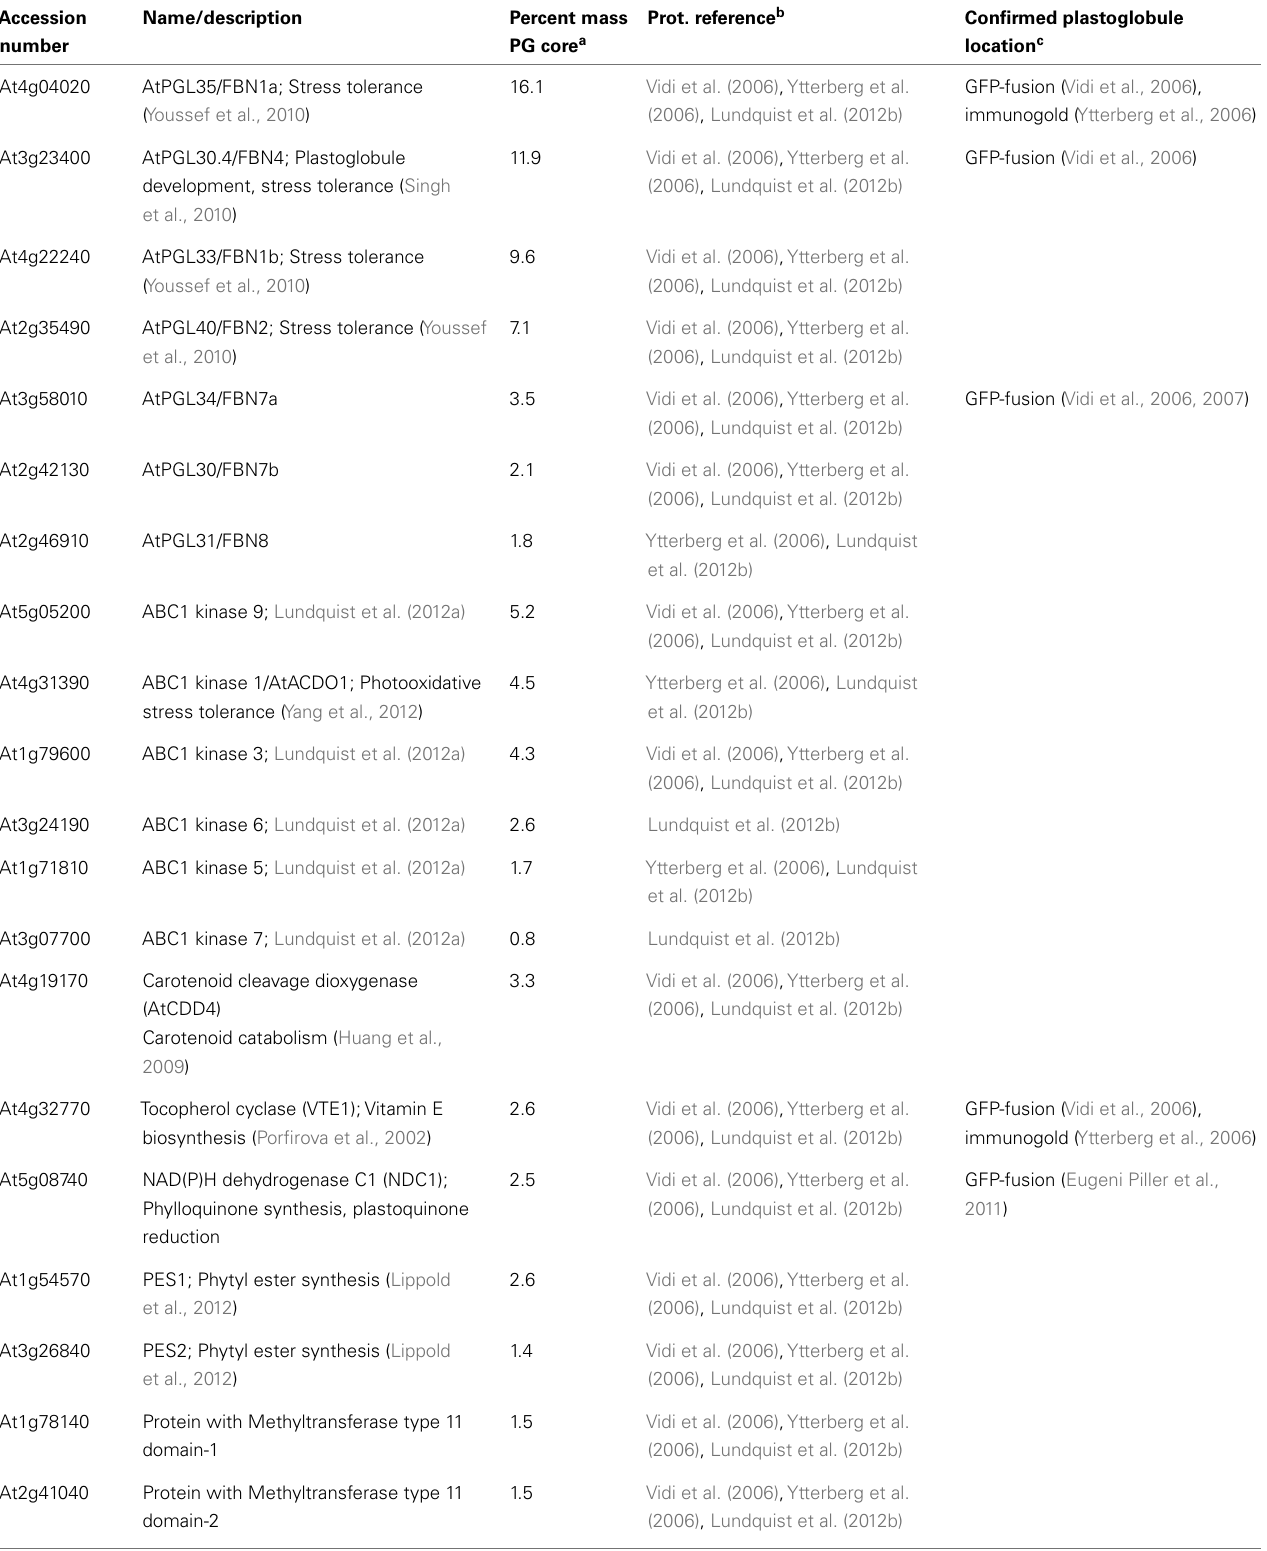
Table 1 |The chloroplast plastoglobule proteome determined by different proteomic